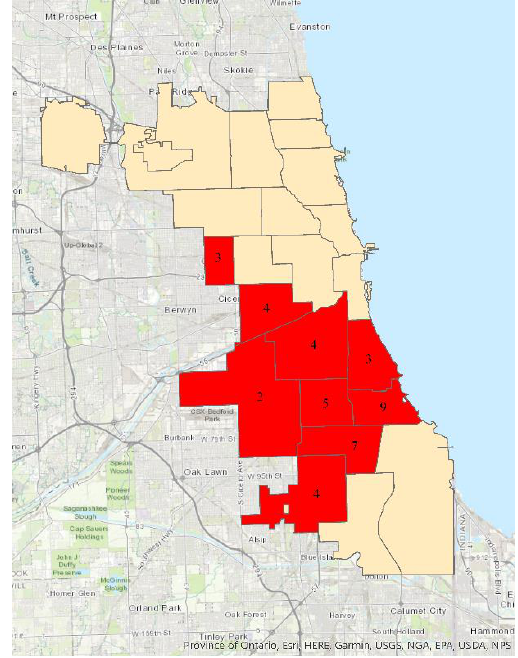
Figure 8. High value clusters by 2-hour interval in a day at police district level